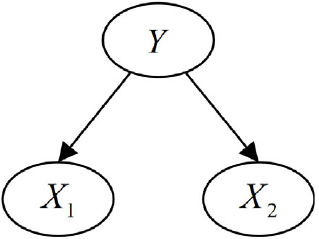
Figure 1. A typical ordinary Bayesian network.